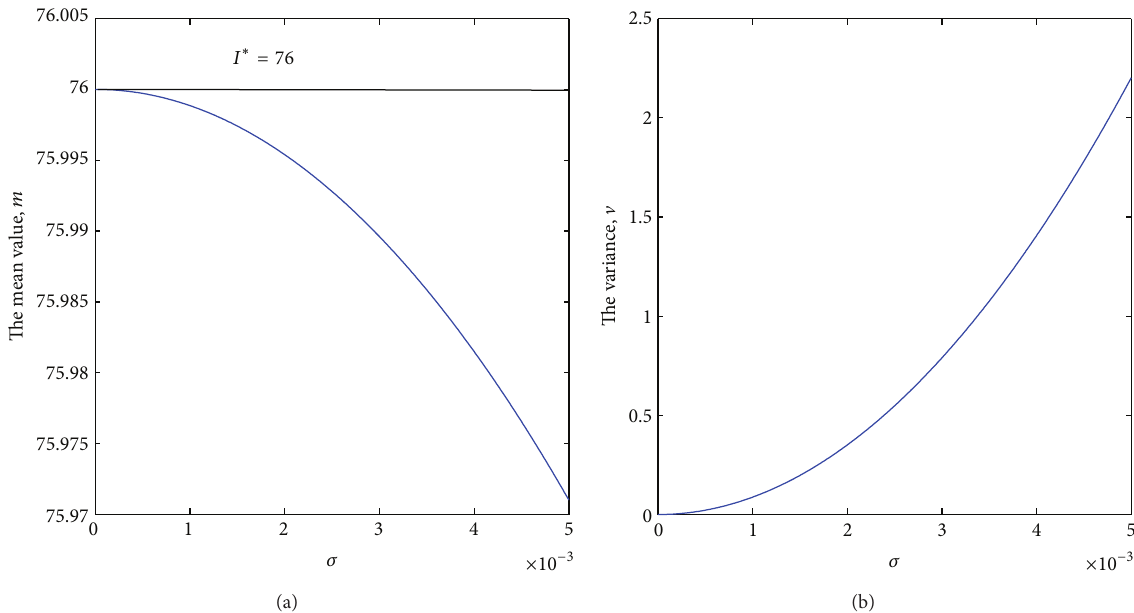
Figure 6: Plot the mean 𝑚 and variance V against 𝜎 . The endemic equilibrium 𝐼 ∗ of the deterministic model (1) is 76.